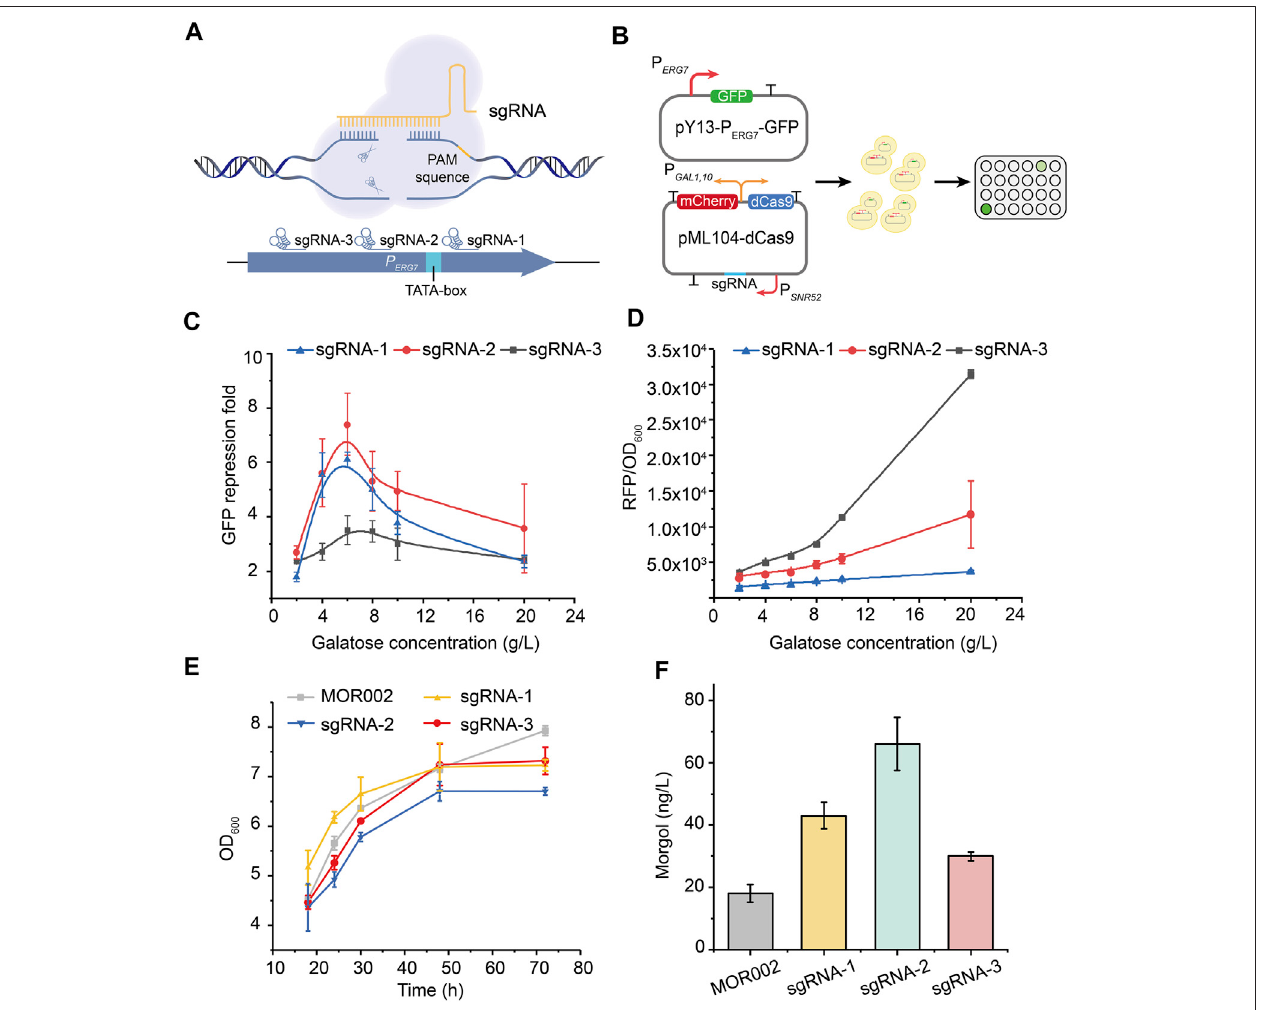
FIGURE 4 | Repression of the lanosterol biosynthesis pathway by the CRISPRi system. (A) CRISPRi was employed to repress gene expression by an inactive Cas9 protein (dCas9), which can bind to a speci fi c sequence by sgRNA and block the elongation of RNA polymerase. sgRNAs were chosen from the endogenous ERG7 promoter. (B) ConstructionofplasmidsthatcharacterizethefeasibilityoftheCRISPRisysteminyeastandtheveri fi cationof fl uorescenceina96-well plate. (C) GFP fl uorescence repression fold of different sgRNAs of promoter P ERG7 . (D) mCherry fl uorescence intensity of dCas9 protein. (E) Cell growth curves